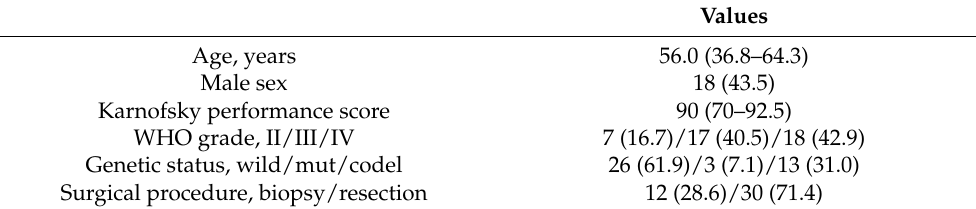
Table 1. Patient characteristics.